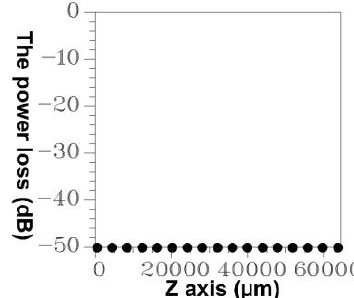
+ L + L = 64,444.4 1 2 3